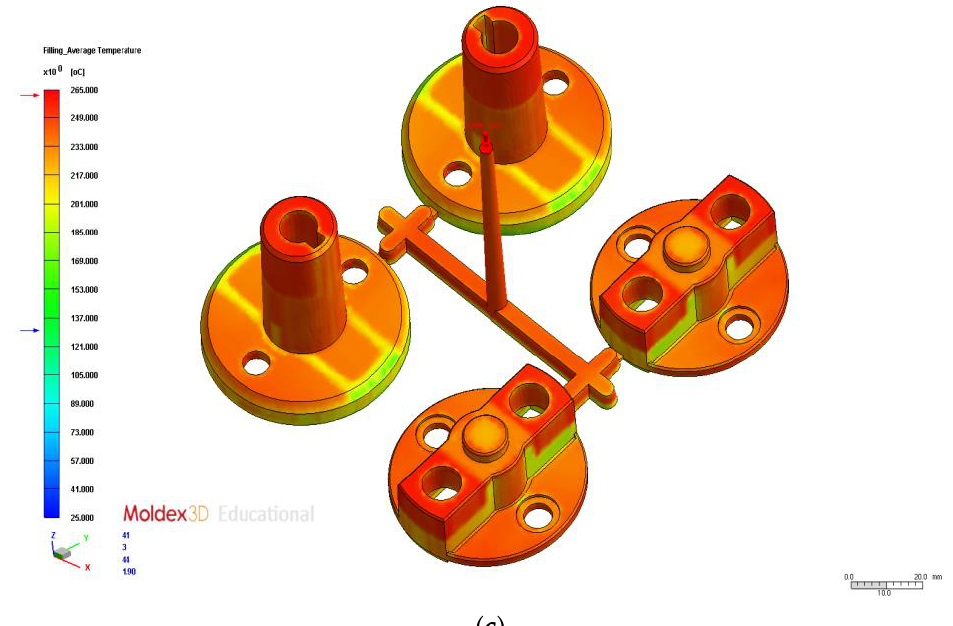
Figure 12. Comparison of Temperature Distributions. ( a ) Original cooling. ( b ) U-shaped cooling. ( c ) Conformal cooling.